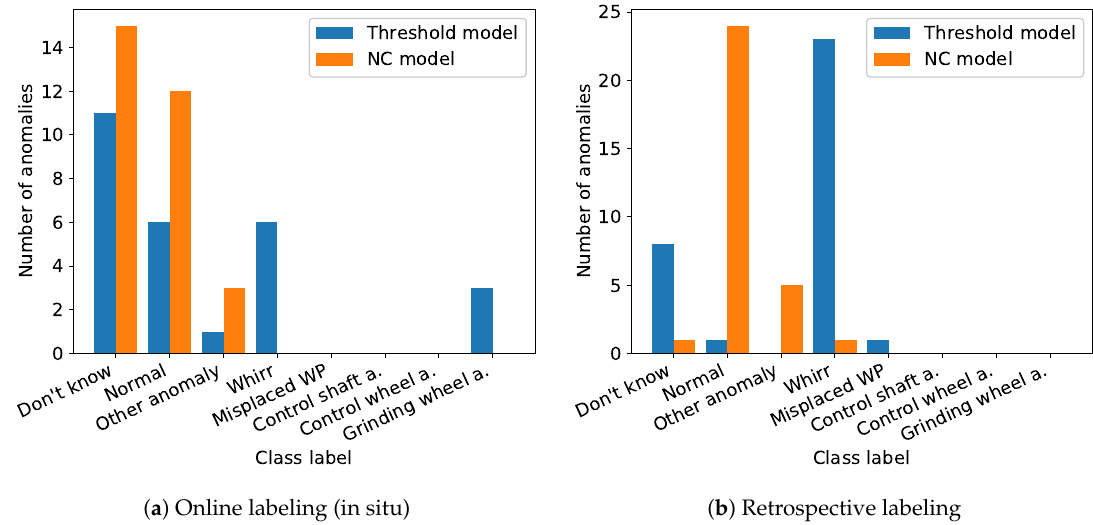
Figure 7. Distribution of annotator feedback across classes (cf. Assumption 1): During retrospective annotation ( b ), labels are given more confidently to clear classes (“Normal”, “Whirr”) than during online annotation ( a